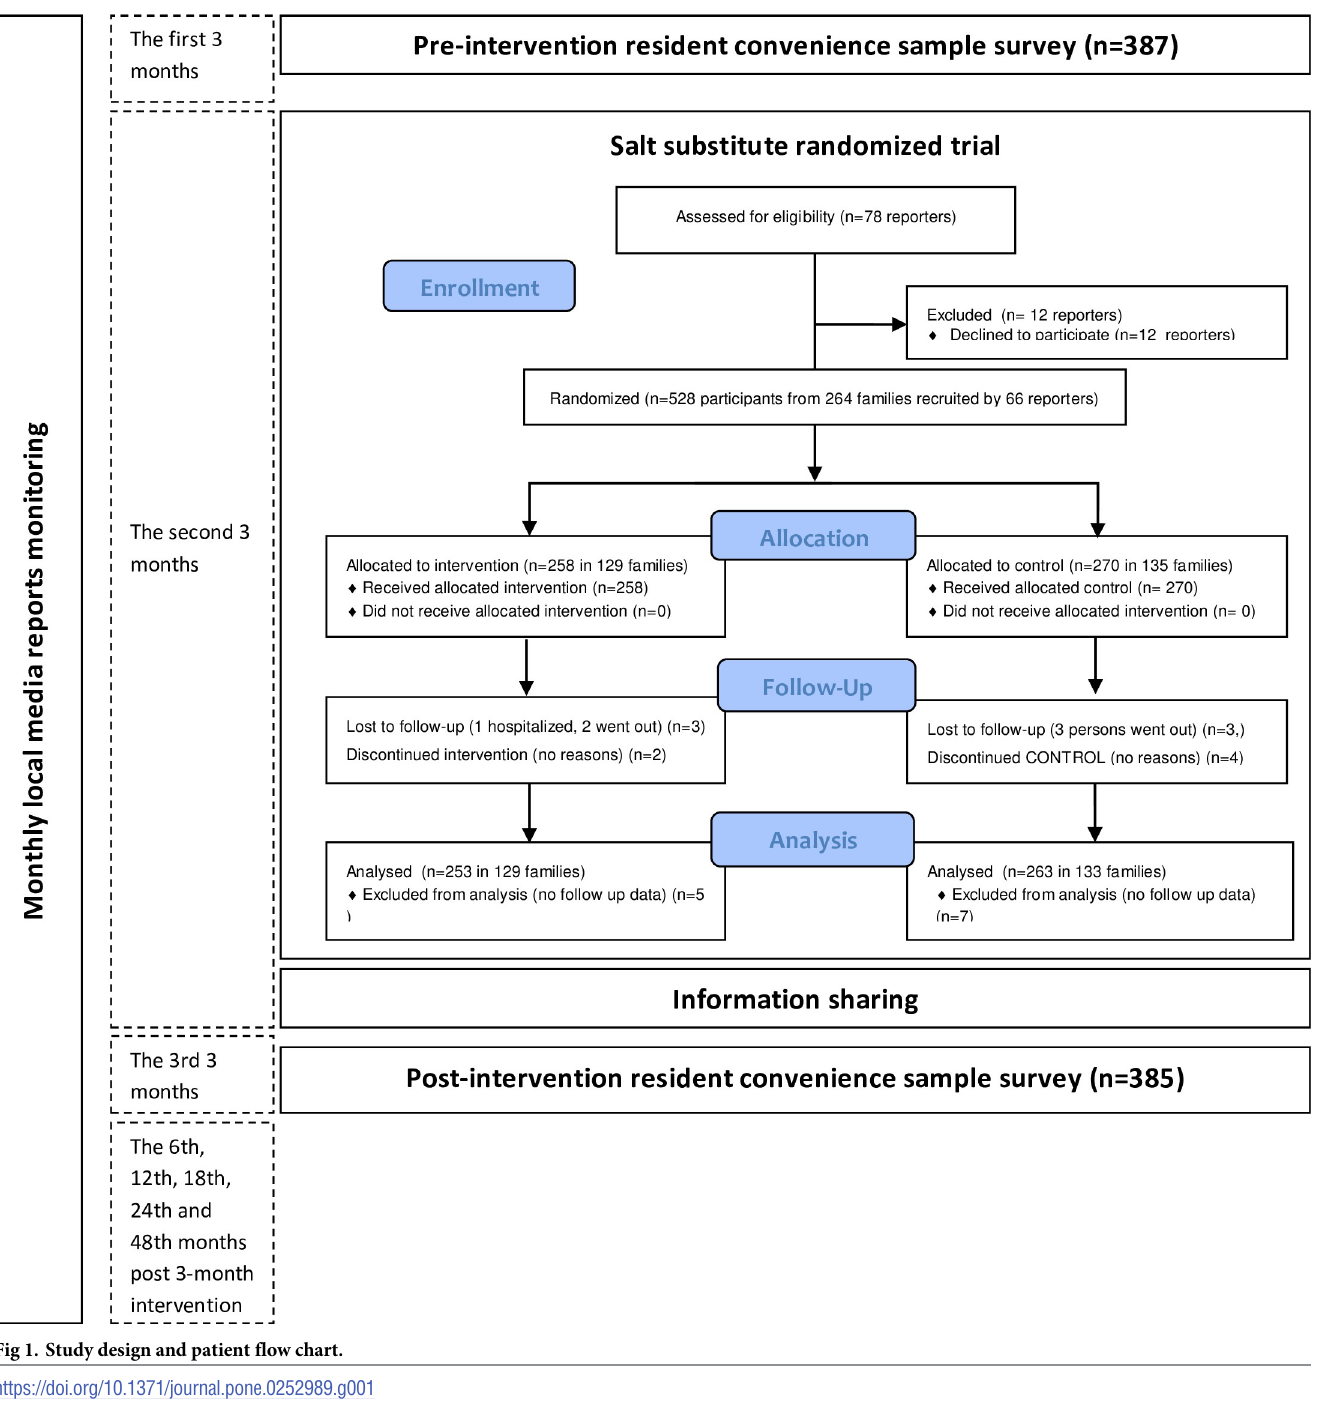
Fig 1. Study design and patient flow